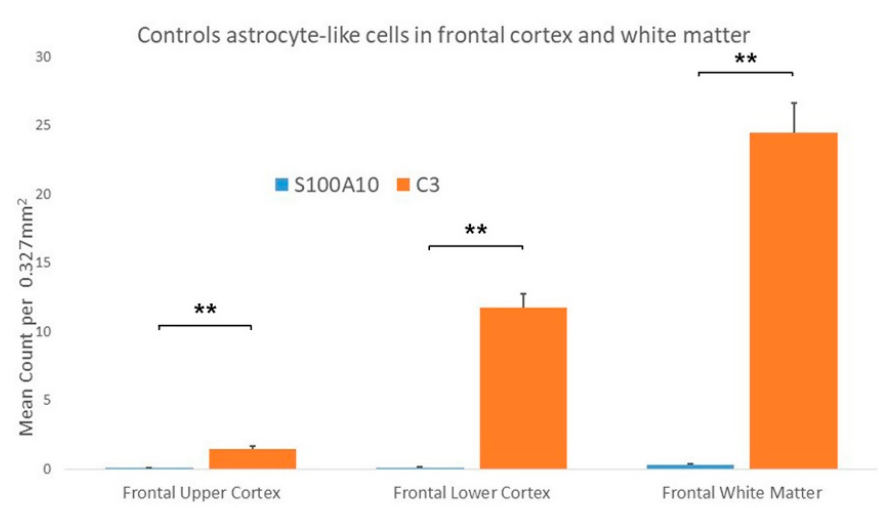
Figure 8. Results comparing the mean counts of C3 and S100A10 immunopositive astrocyte-like cells (ASLCs) in the upper frontal cortex, lower frontal cortex and frontal white matter of control cases. There were significantly increased numbers of C3 immunopositive ASCLs compared to S100A10 immunopositive ASLCs in all regions. (** p < 0.001) Results are mean counts + SEM.